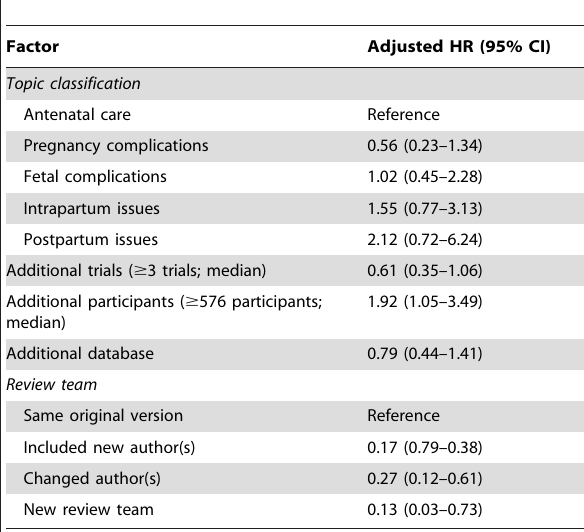
Table 5. Factors predicting time to first update of